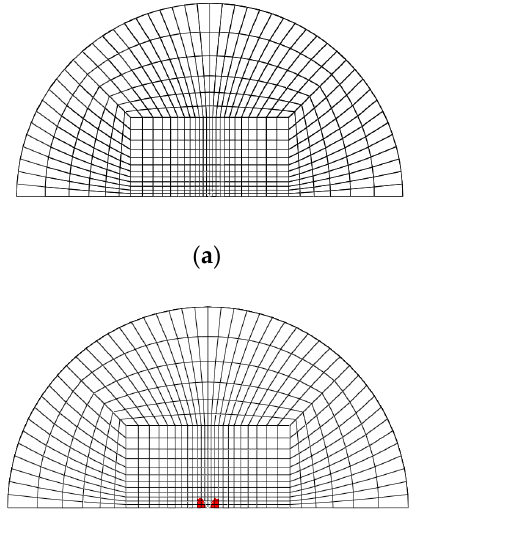
Figure 19. Difference between the predicted and measured central deflection for GLARE 5-2/1 under impact energy of 16 J.